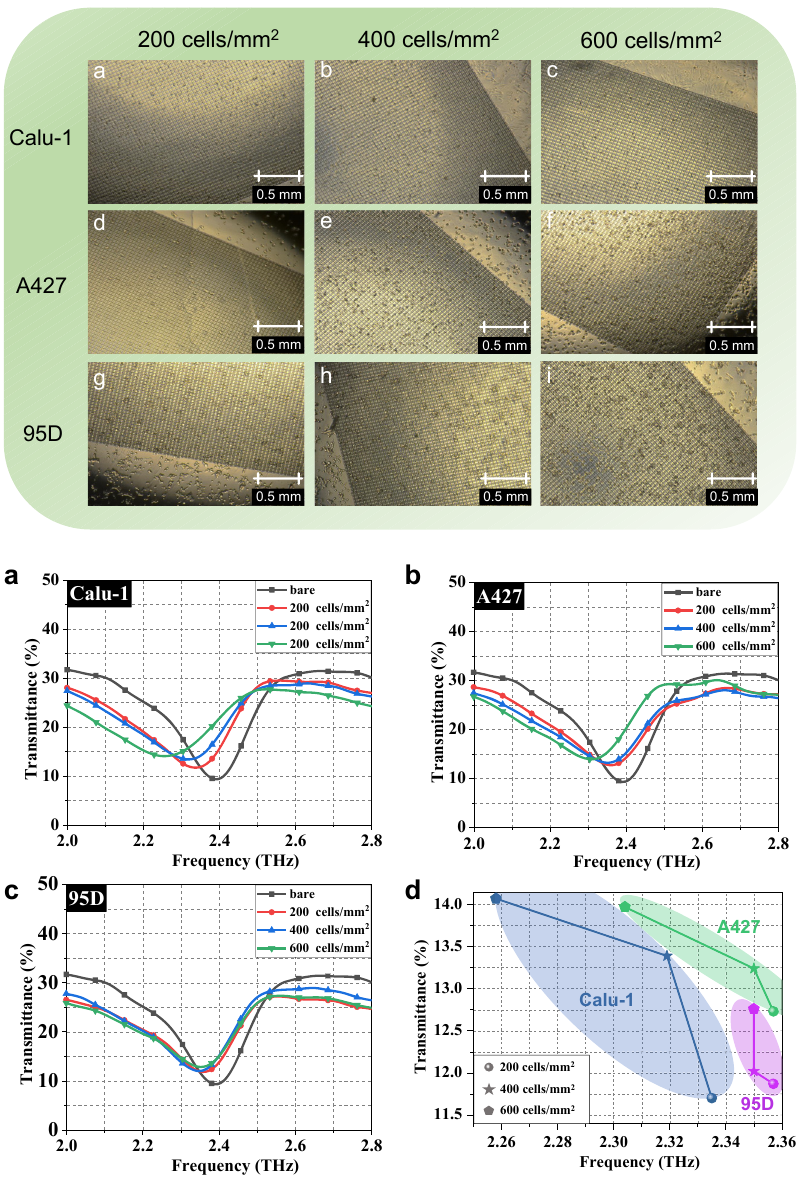
Figure 6: The measured transmission spec- tra of the proposed biosensor covered by three types of lung cells including (a) Calu- 1, (b) A427, and (c) 95D with concentrations of 200 cells/mm 2 , 400 cells/mm 2 , and 600 cells/mm 2 . (d) The shifts of frequency and transmittanceoftheresonancedipasthecel- lularconcentrationchangesforCalu-1(blue), A427 (green), and 95D